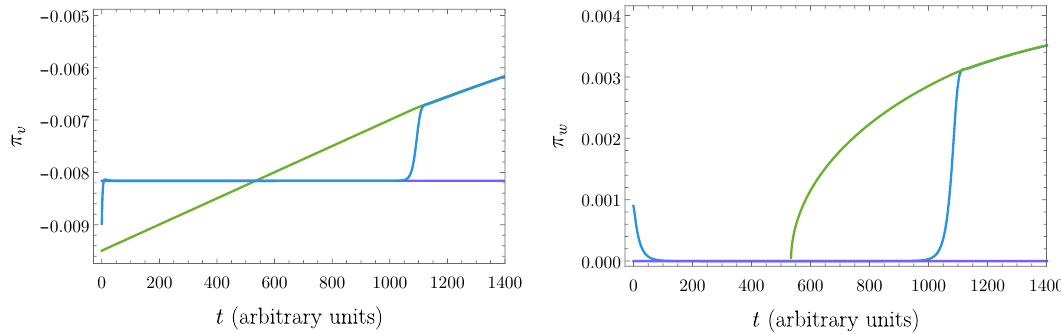
Figure 1 . The analytical predictions from hyperin(cid:13)ation (green) and slow-roll in(cid:13)ation (purple) together with a numerical realisation of example 2 (blue). The momenta are quickly attracted to the slow-roll solution, but then destabilise and approach the hyperin(cid:13)ation attractor. radius, and until (cid:30) = O ( L ). This metric is easy to work with everywhere in the hyperbolic plane, and here we explore more general initial